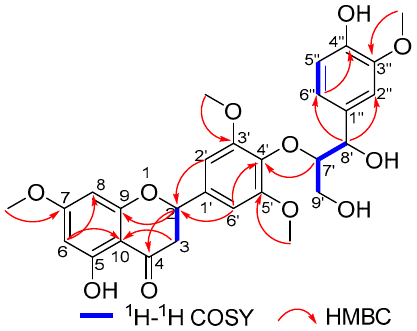
Figure 4. 1 H– 1 H COSY and key HMBC correlations of 2 .